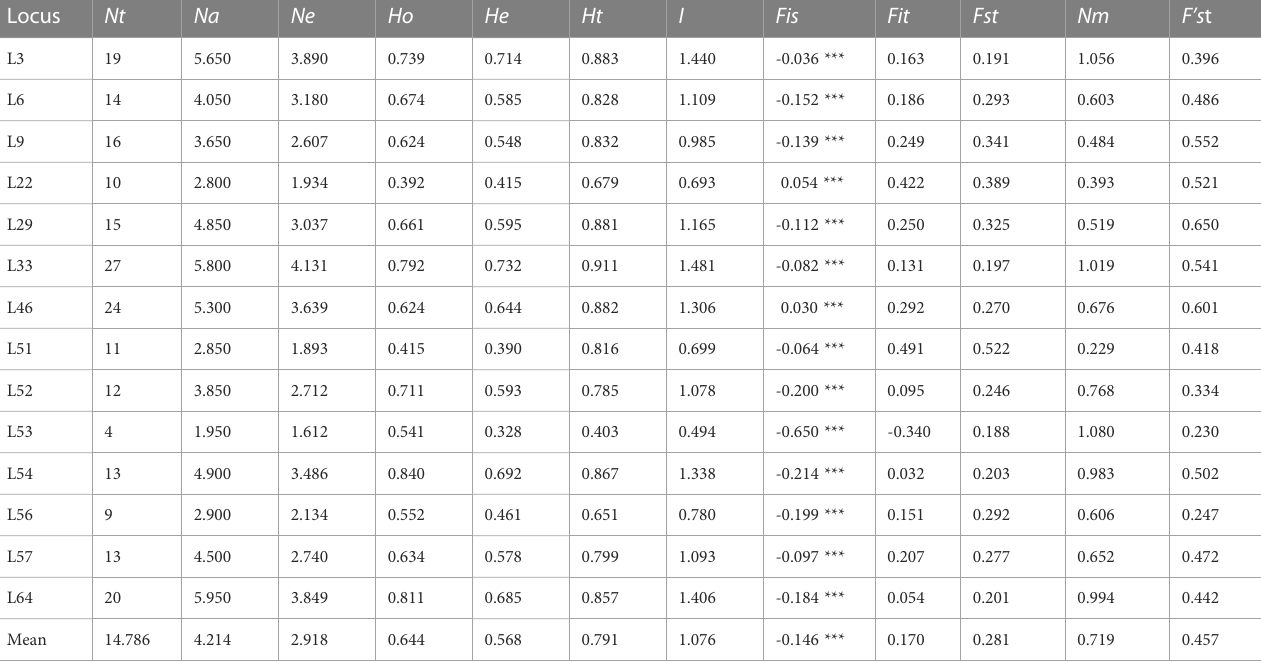
TABLE 2 Genetic diversity metrics among all samples (n = 323) and across all 14 microsatellite loci used in this study. Locus